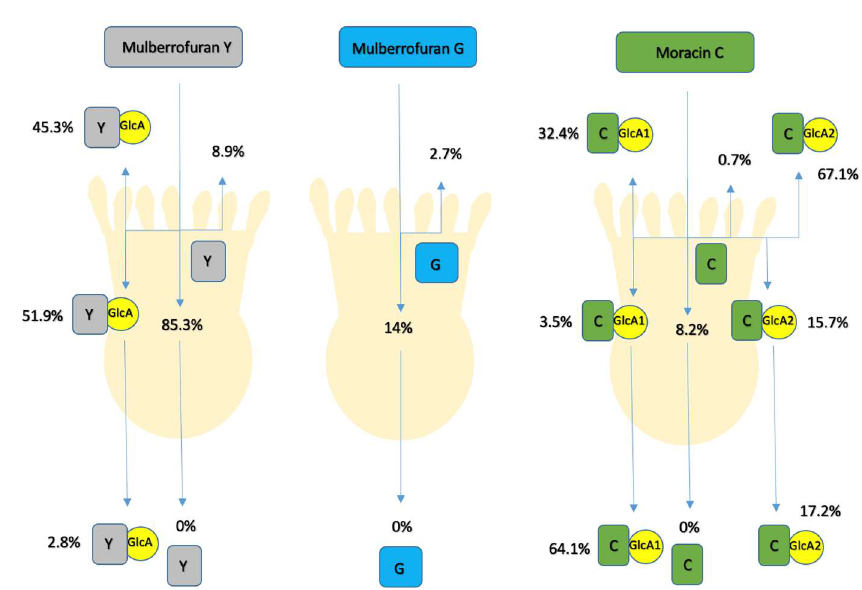
Figure 2. The fate of mulberrofuran Y ( 1 ), moracin C ( 2 ), and mulberrofuran G ( 3 ) after 4 h of the experiment in the Transwell TM cell system. Y: Mulberrofuran Y ( 1 ), G: Mulberrofuran G ( 3 ), C: Moracin C ( 2 ), GlcA: Glucuronide conjugation.